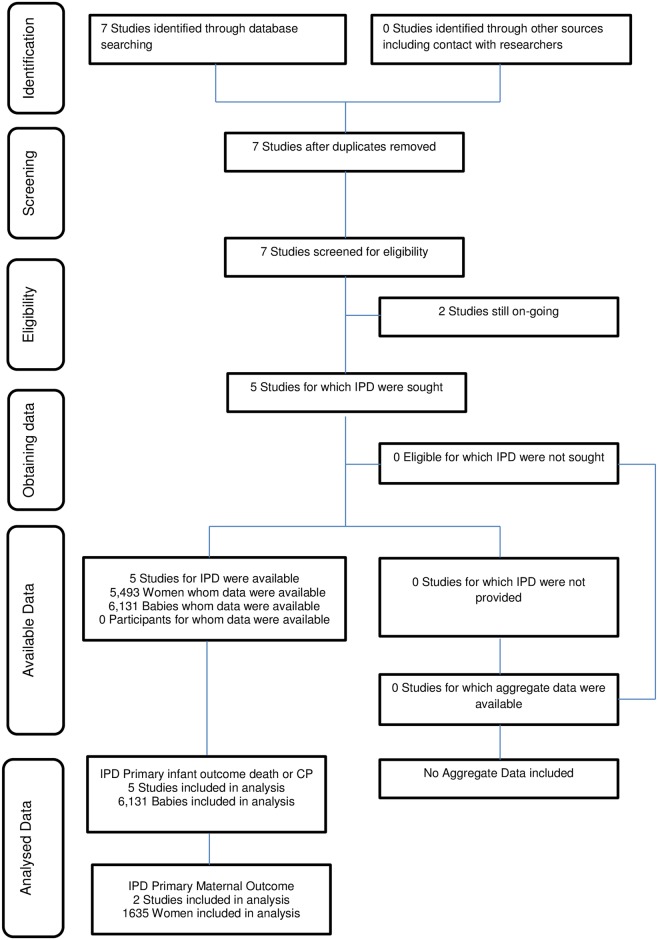
Preferred Reporting Items for Systematic Review and Meta-analyses of Individual Participant Data (PRISMA-IPD) flow diagram.Abbreviations: CP, cerebral palsy.